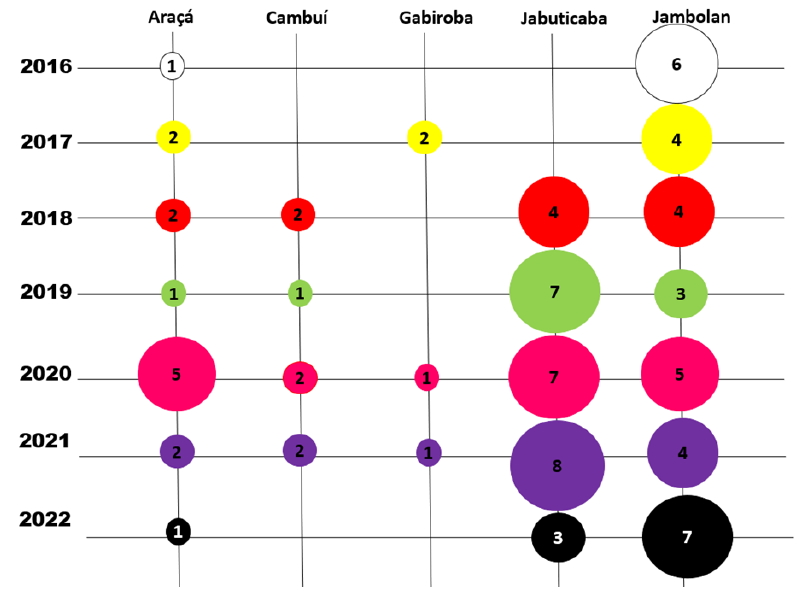
Figure 7. Bubble chart showing the number of selected publications in a specific yearly period (Authors, 2022).